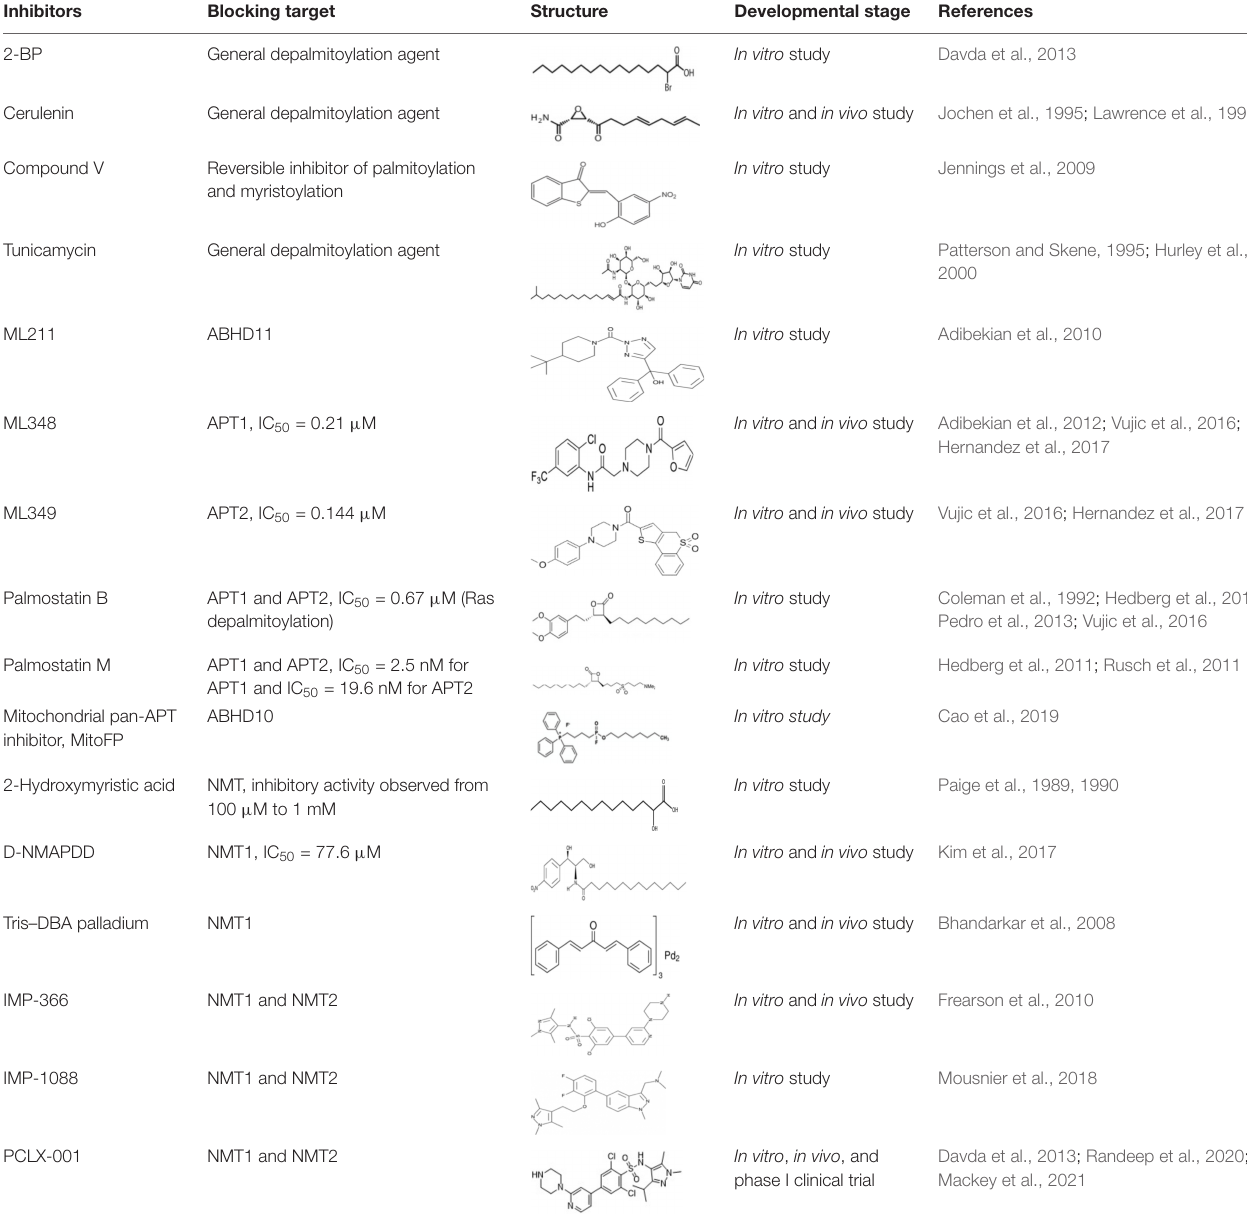
TABLE 3 | Summary of PAT, APT, and NMT